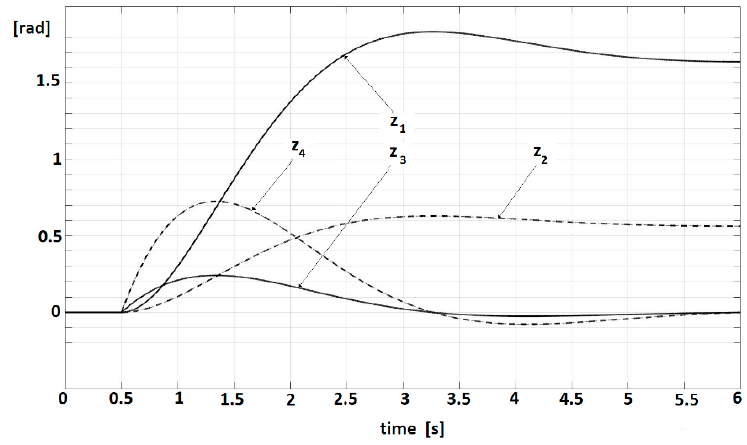
Figure 5. Motion trajectories for TDFOLS model ( 𝝉 = 0.5s).